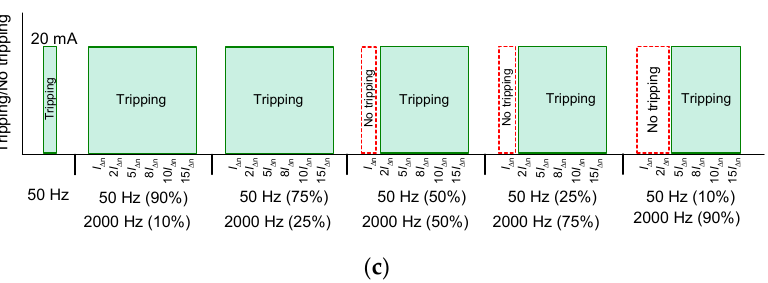
Figure 11. Tripping of the 30 mA F-type RCD (no. RCD_1F—symbol defined in Table 2) for wave- form composed of the fundamental frequency (50 Hz) and high-frequency component: ( a ) 500 Hz; ( b ) 1000 Hz; ( c ) 2000 Hz. Values in brackets indicate the content of the particular component; 20 mA— real tripping current for a pure sinusoidal signal of 50 Hz.